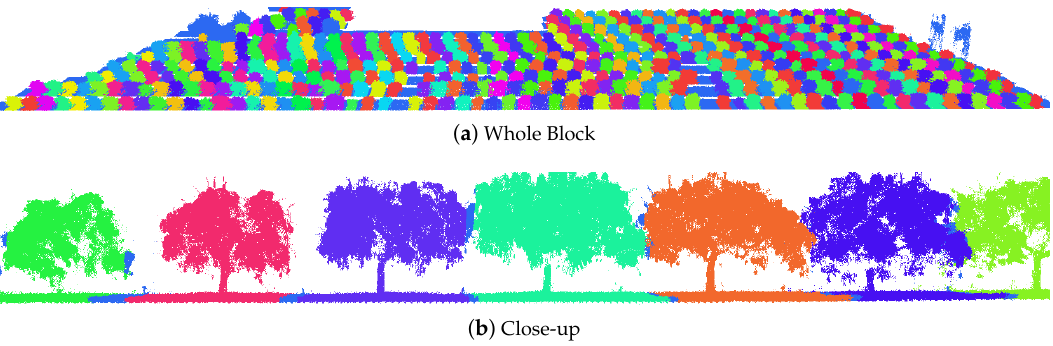
Figure 3. Segmented mango-tree LiDAR data, coloured by the tree count from the north headland to the right of the image. The whole block is shown in ( a ); and a close-up view of several trees in ( b ). Light blue bands indicate the boundary between trees.